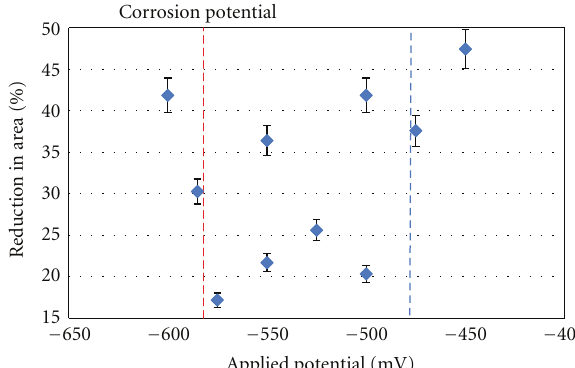
Figure 10: Reduction in area as a function of the applied electrochemical potential at 800kPa and 45 ◦ C with a gas mixture of 25% CO and 75% CO.